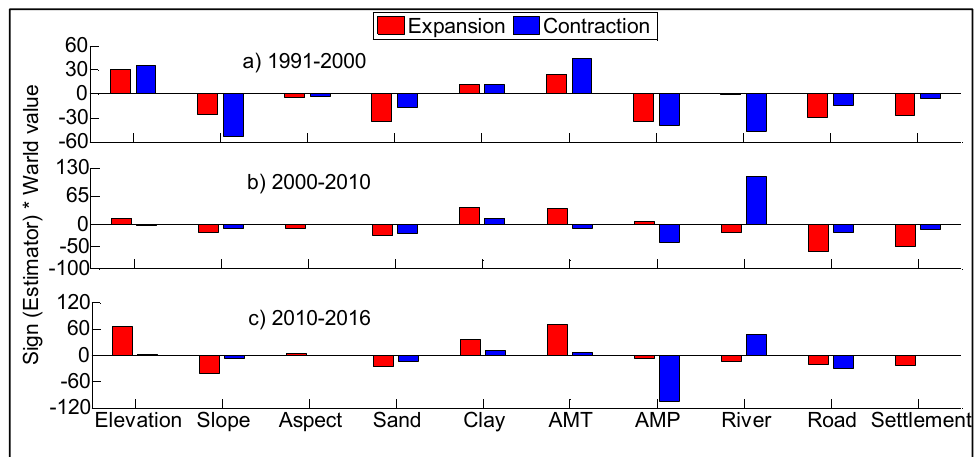
Figure 9. Comparative analysis of the relative importance of different factors driving the farmland expansions and contractions within the DPR Korea TRB region.